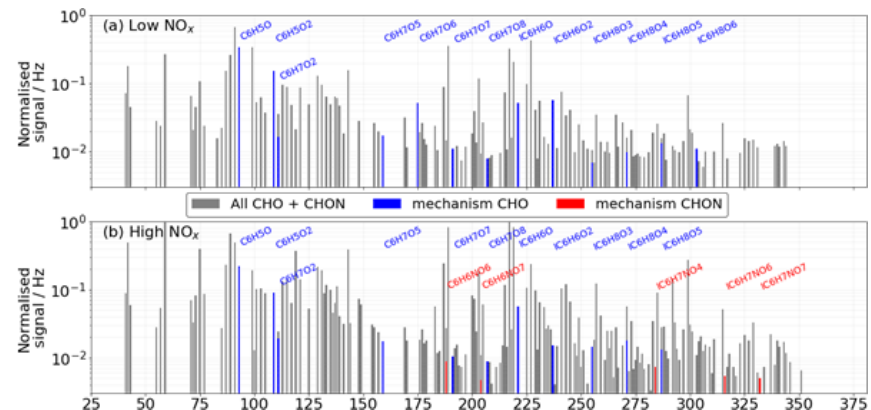
Figure 5. Unit mass spectra of (a) low-NO x and (b) high-NO x experiments from the iodide CIMS. Detected ions from the mechanism are highlighted as CHO (blue) or CHON (red).